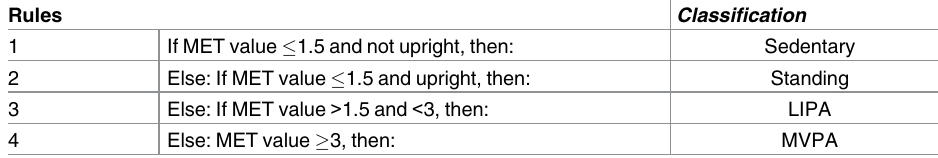
Table 2. Cut-off point algorithm classification